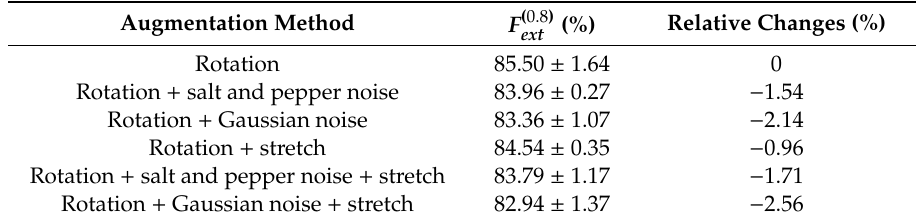
Table 3. 𝐹 (cid:3032)(cid:3051)(cid:3047)((cid:2868).(cid:2876)) of the models trained on datasets augmented by different combined methods. Twenty original images are used, and the data augmentation factor 𝑓 is 96.